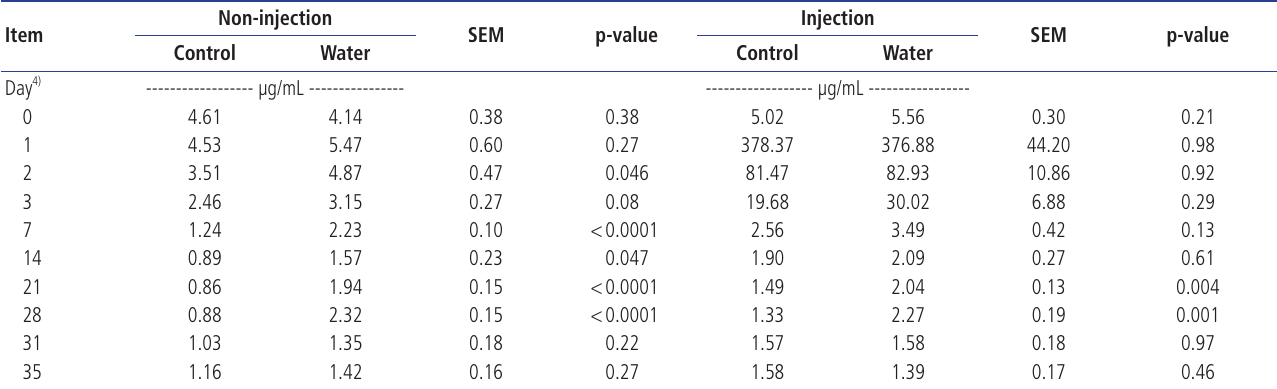
and E administration in drinking water within vitamin A, D , E injection 3 3 Injection SEM p-value